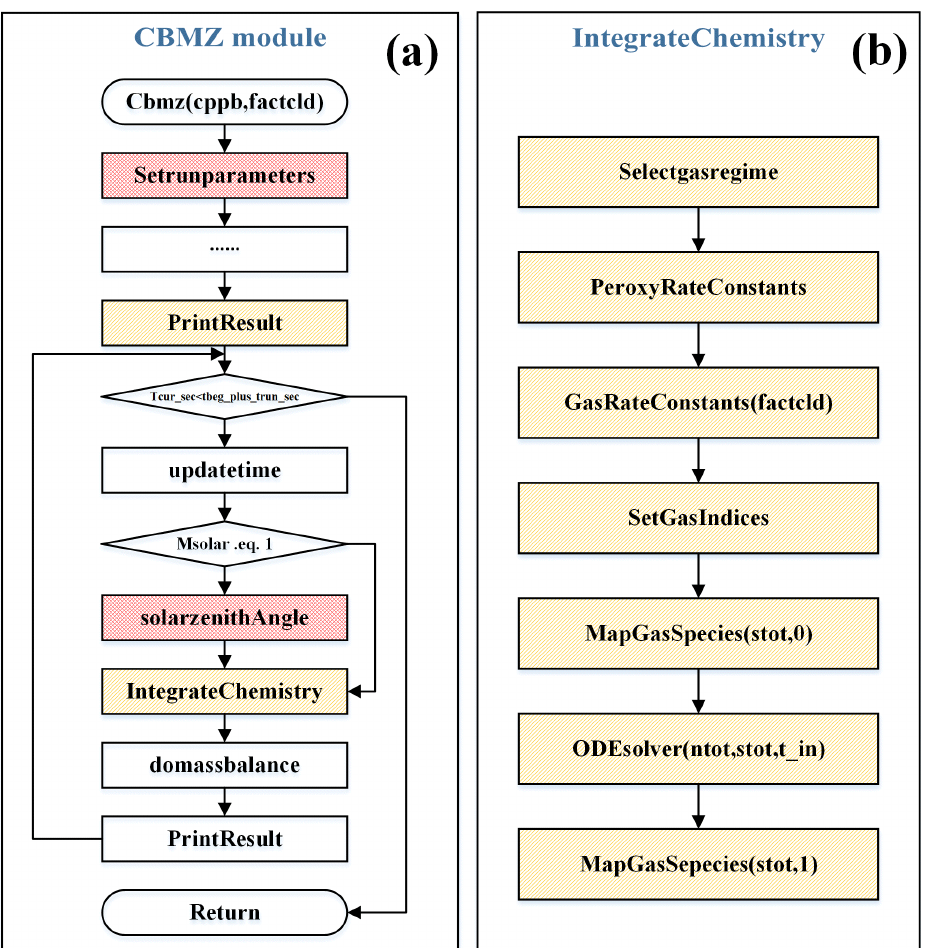
Figure 4. Flowcharts of the CBM-Z module (a) and the IntegrateChemistry subroutine (b) . The red subroutines were removed and made into inline functions, and the orange parts were modified for